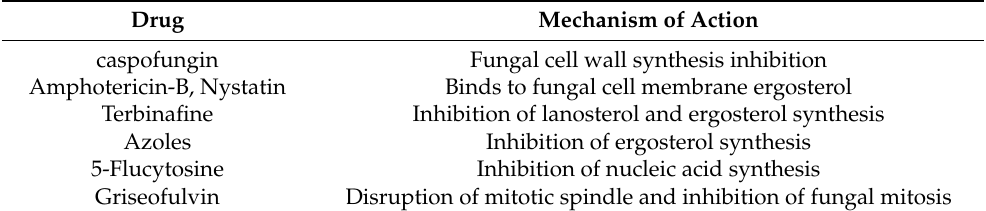
Table 4. Mechanism of action of systemic antifungal